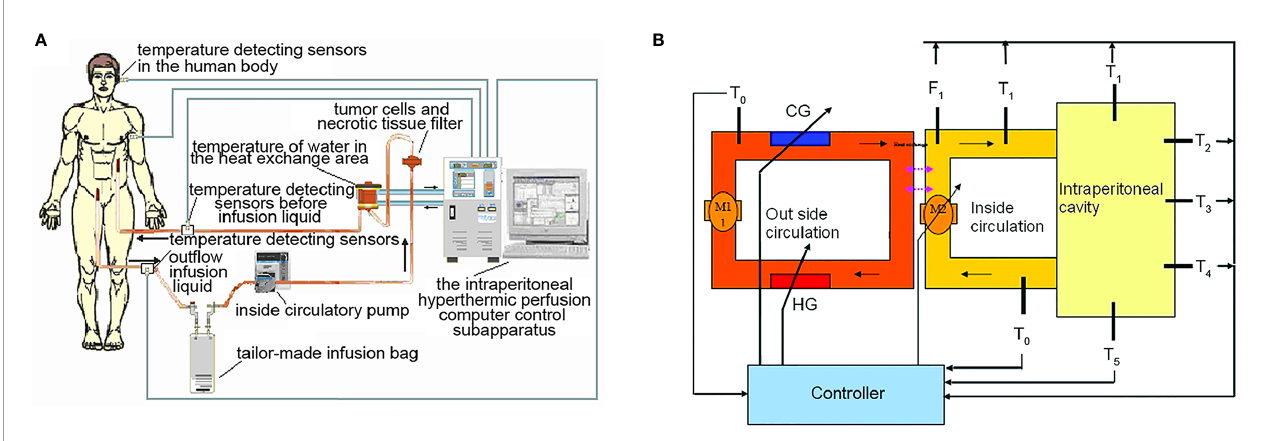
FIGURE 1 | The BR-TRG-I-type intraperitoneal hyperthermic perfusion chemotherapy device. Sketch map and stucture chart. (A) Sketch map, (B) stucture chart. HG: heater, with a maximum power of 4 kW; adjustable heating current. CG: semi-conductor refrigerator, with a maximum power of 2 kW; adjustable refrigerating power. T°: temperature of water in the external heat exchanger, with a precision of 0.1°C. Tii: temperature of the internal circulatory perfusate before entering the body, precision of 0.1°C. Ti°: temperature of the internal out fl ow perfusate, with a precision of 0.1°C. Fi: fl ow rate of the internal circulatory perfusion liquid, with a precision of 10 ml/min; resolution of 1 ml/min. P: the pressure of the internal perfusate before entering the human body, with a precision of 10 mmHg; resolution of 1 mmHg. T 1 -T 5 : temperature of fi ve important parts of the human body. M1: external circulatory pump, constant working rate of 10 L/min. M2: internal circulatory pump, rotating rate, maximum controllable rate, 600 ml/min; precision of 10 ml/min; resolution of 1